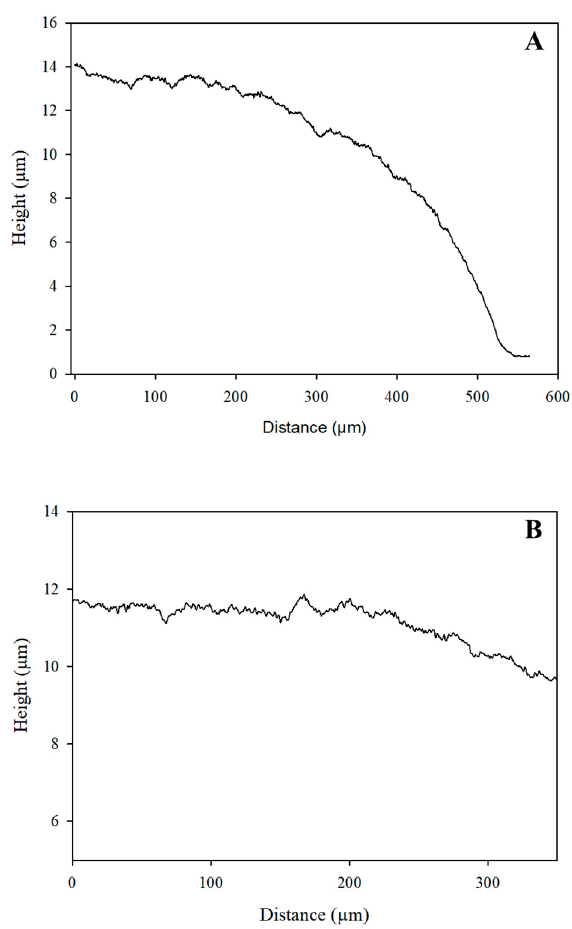
Figure 4. 2D profile of the electrode: ( A ) step height and ( B ) surface